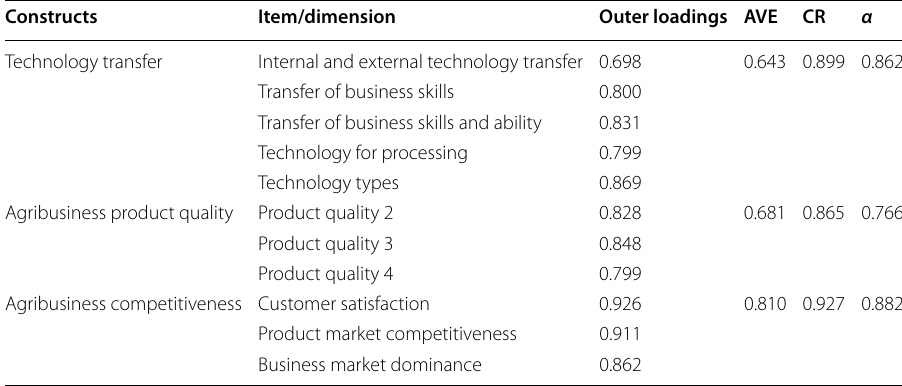
Table 1 The model’s convergent validity Constructs